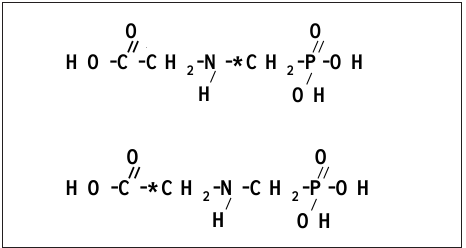
Figure 1. 14 C-Glyphosate [n-(phosphonomethyl) glycine]. * Position of 14